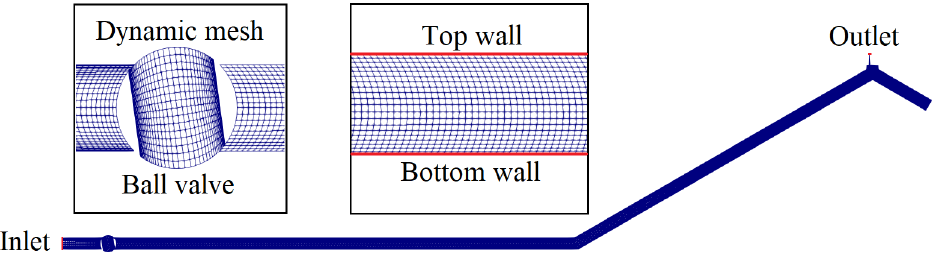
Figure 3. Geometric domain, mesh, and boundary conditions of the